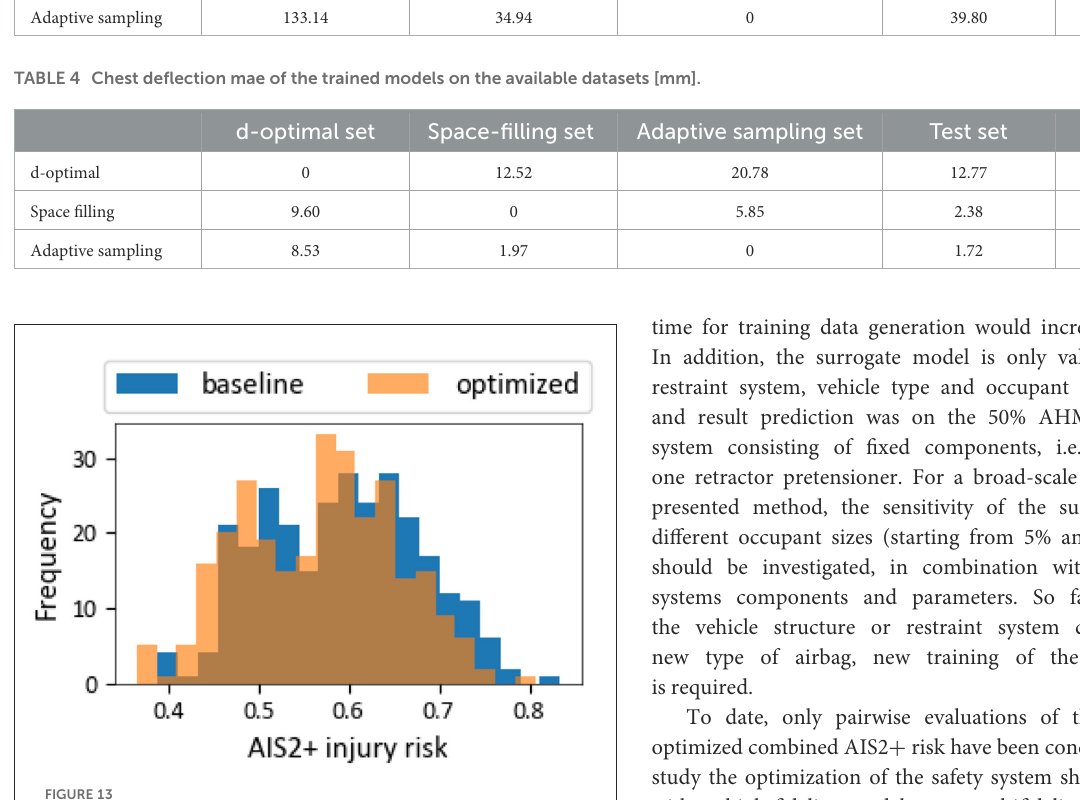
simulations, even though the predicted injury values deviate from the actual